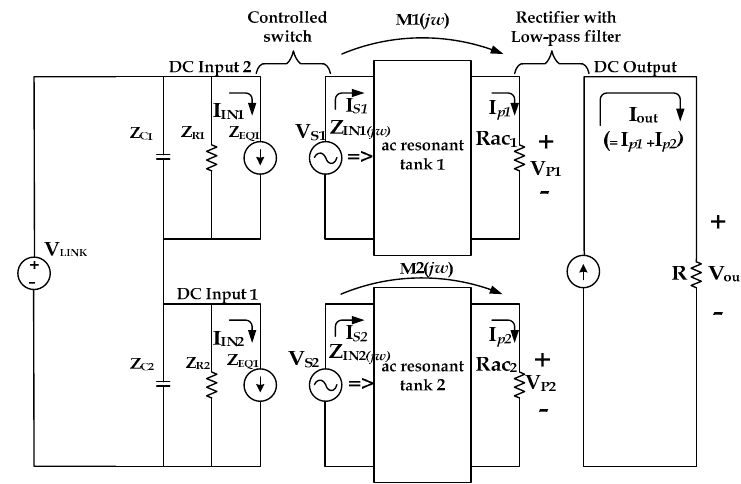
Figure 3. Equivalent circuit of the auto-balancing LLC resonant DC/DC converter.